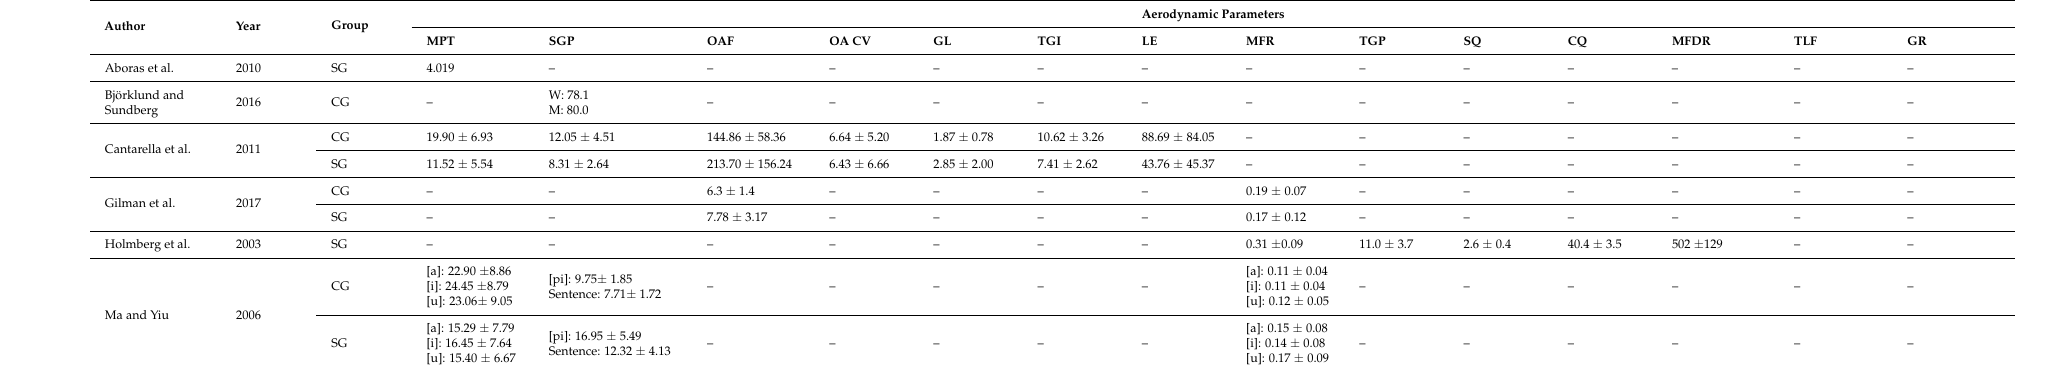
Table 5. Summary of the results of the included studies in terms of aerodynamic